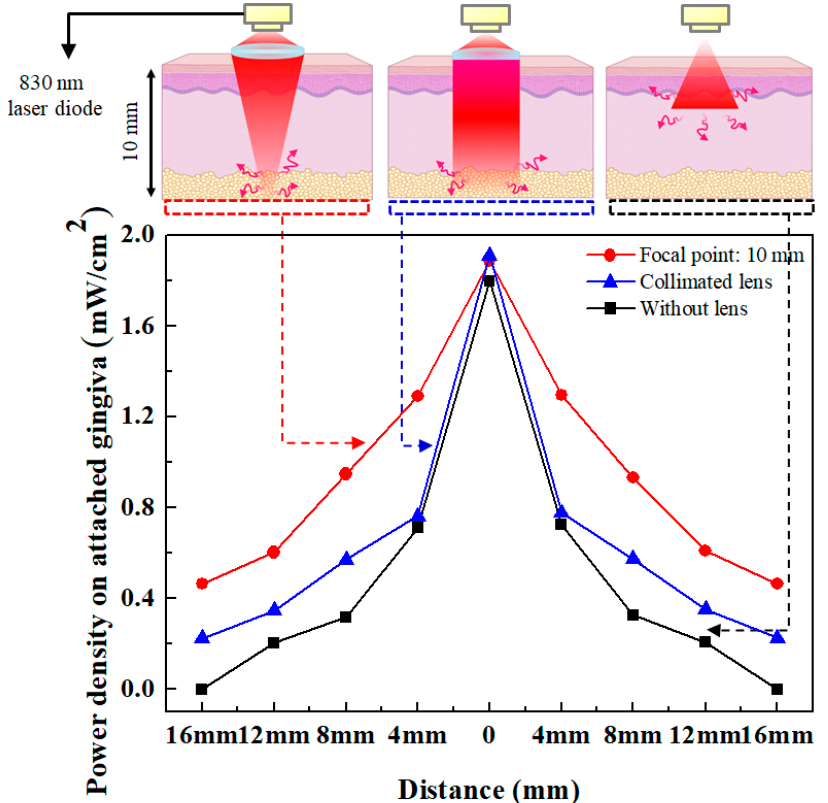
Figure 6. Power densities distribution of the 830 nm laser with a different laser beam penetrating the orbicularis oris. Schematics were created with BioRender.com.